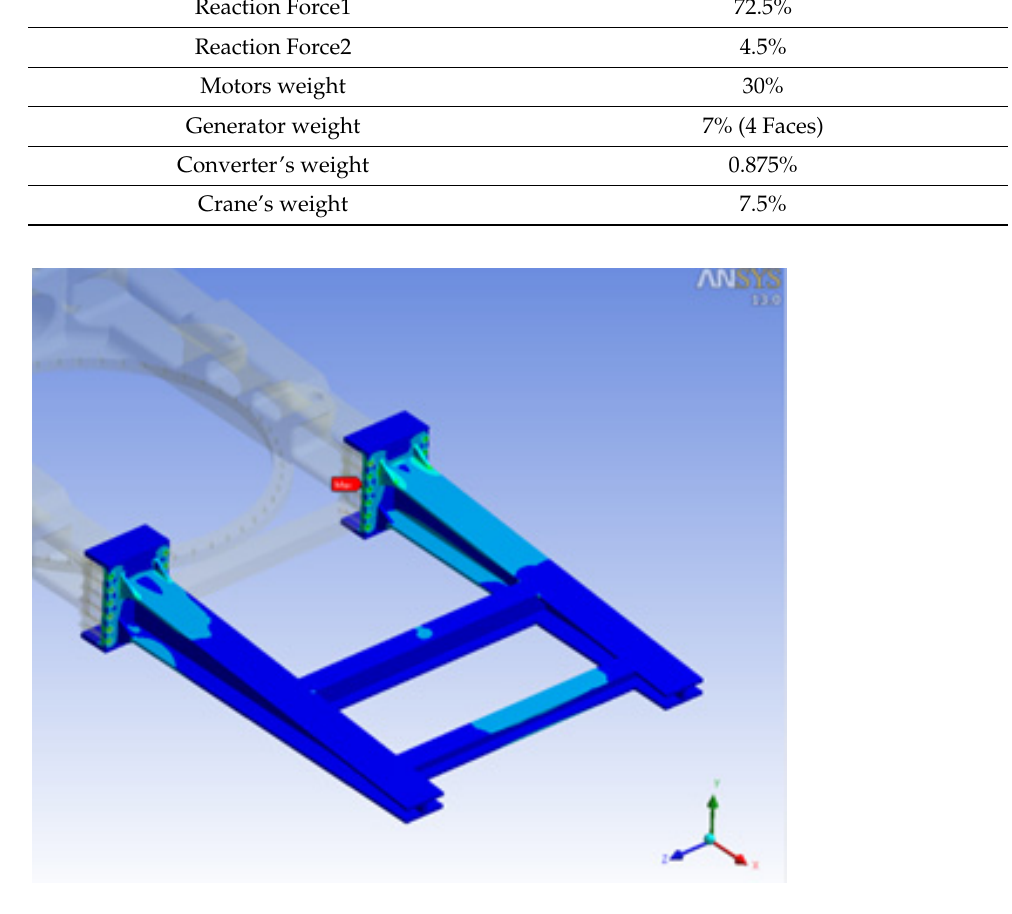
Figure 11. Minimum stress on the welded frame [30].